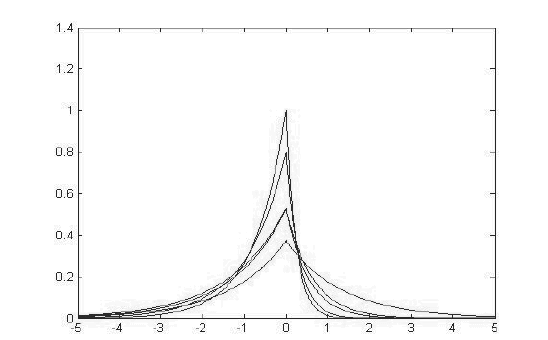
Figure 2 – Approximated Asymmetric Laplace densities, =1  and  = 0,-1,-1.5,-3,-4 and  = 0.8,1.8,2,5,8 which corresponds to  =